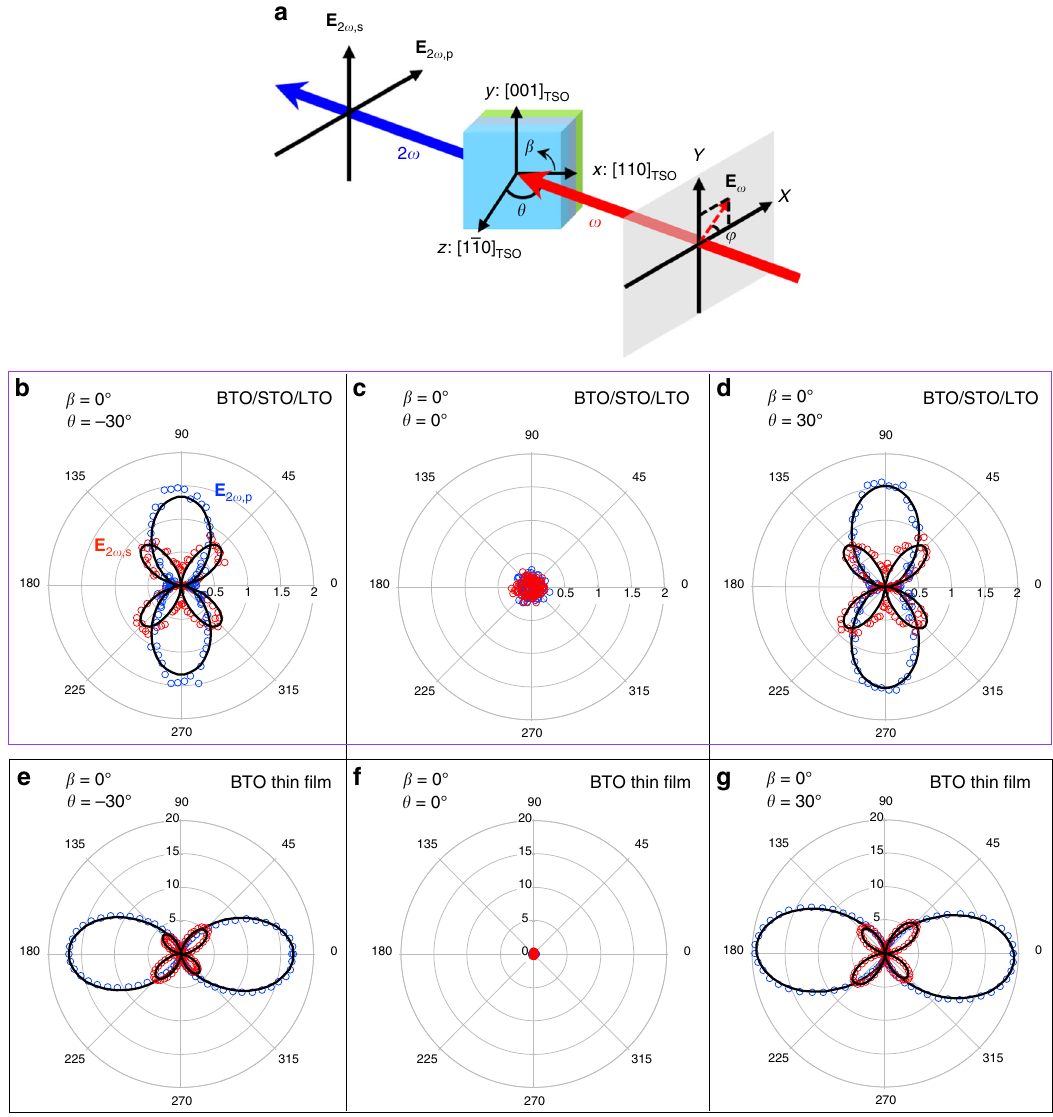
Fig. 2 SHG polarimetry measurement. a Schematics of the far- fi eld transmission SHG setup with crystallographic directions of TbScO 3 substrate (subscript TSO) under sample coordinates ( x , y , z ). E 2 ω ,p (blue circles) and E 2 ω ,s (red circles) SHG signal on ( b – d ) BTO/STO/LTO and ( c – g ) BTO thin fi lm (10 unit cells) are measured by rotating the incident polarization φ under three different incident angles θ = − 30°, 0°, 30°. Data with β = 0° are plotted here (see Supplementary Fig. 3a – f for β = 90°). Theoretical modeling of SHG signal (black solid lines) indicates 4 mm point group symmetry for BTO/STO/LTO with effective nonlinear optical coef fi cients d 33 / d 15 ≈ − 13.9, d 31 / d 15 ≈ 1.3. In comparison, SHG signal on BTO thin fi lm exhibits mm 2 point group symmetry with d d ≈ 5.2, d d ≈ 33 / 15 31 / 15